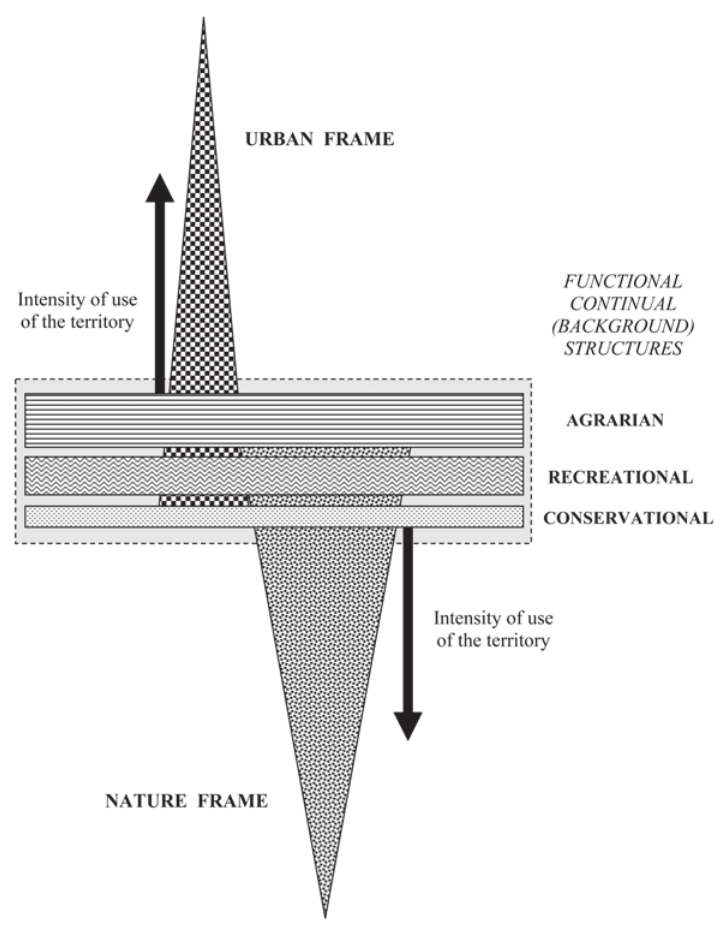
Fig. 1. Principal scheme of sustainable spatial structure of the